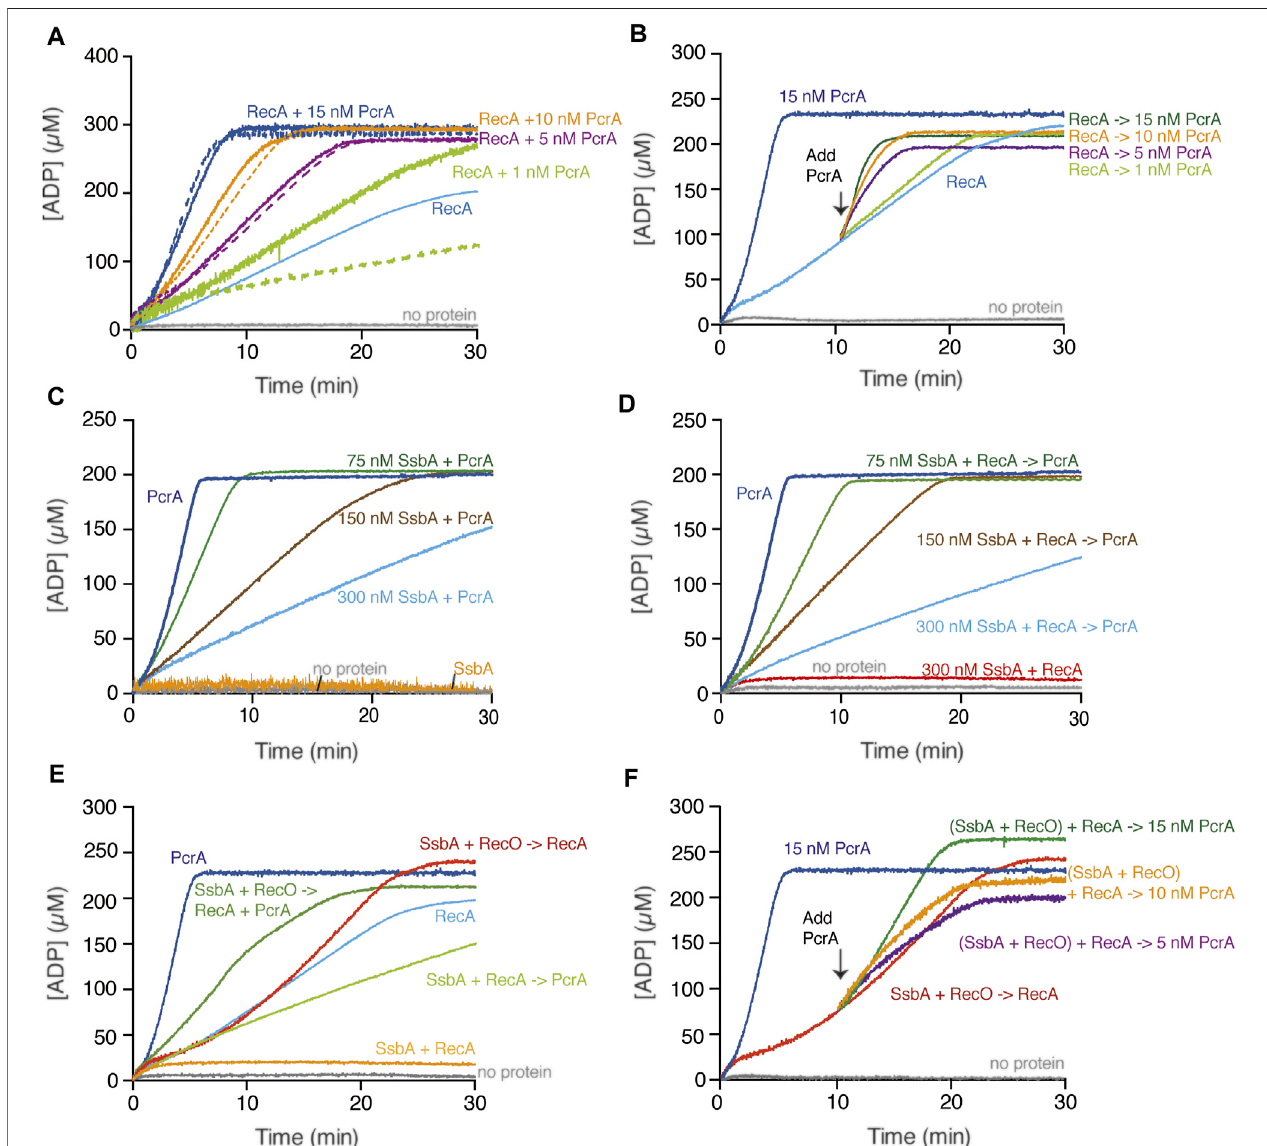
FIGURE 2 | PcrA translocates on the ssDNA in the presence or absence of RecA. (A,B) PcrA (1 – 15 nM), RecA (800 nM), or both proteins were incubated with cssDNA (10 μ M in nts) in buffer A containing 5 mM ATP (A) ; or RecA and cssDNA were pre-incubated (10 min, 37 ° C) in buffer A containing 5 mM ATP, and then increasing PcrA concentrations were added (B) . The grey line denotes the control reaction corresponding to the ATPase assay in the absence of any protein, and the brokenlinesrepresentthepresenceofonlyPcrAattheindicatedconcentration (A,B) . (C) ThecssDNAwasincubatedwith fi xedPcrA(15 nM)andincreasingSsbA concentrations in buffer A containing5 mM ATP. (D) The cssDNA was pre-incubated with fi xed RecA and increasing SsbA concentrations (5 min, 37 ° C) in buffer A, and then PcrA and 5 mM ATP were added. (E) The cssDNA was pre-incubated with fi xed SsbA (300 nM) and RecO (100 nM) or RecA (5 min, 37 ° C) in buffer A containing 5 mM ATPand then PcrA (15 nM), RecA (800 nM) or both,and 5 mM ATPwere added. (F) The cssDNA waspre-incubated with RecA, SsbA, and RecO (10 min, 37 ° C) in buffer A containing 5 mM ATP, and then PcrA (5 – 15 nM) was added. Buffer A contained the NADH enzyme mix. The ATPase activity was measured (30 [or 20] min, 37 ° C). Representative graphs are shown here, and the determined K cat is described in the